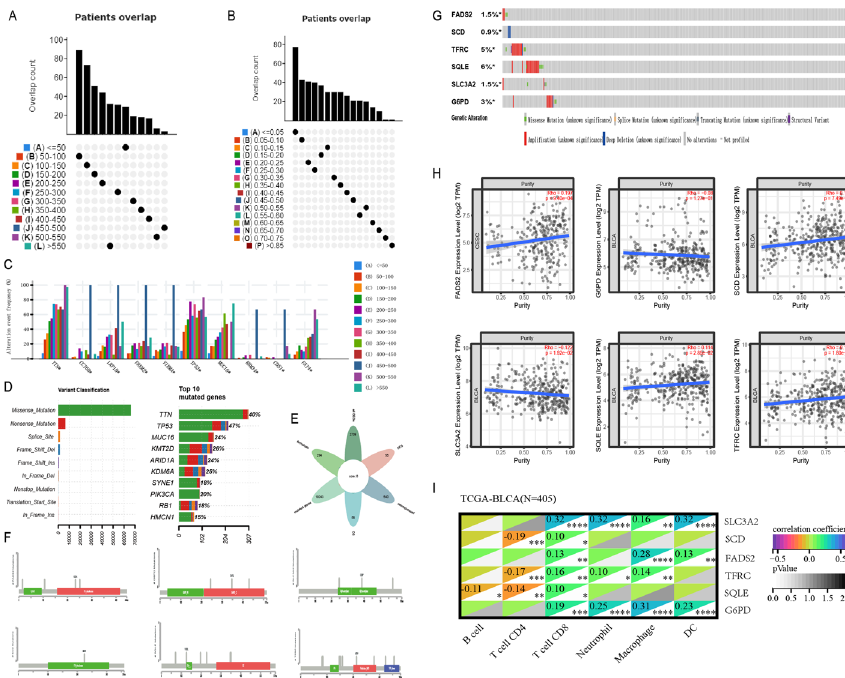
Fig. 3 Identification of potential tumor‑specific antigens of BCa. Samples overlapping in A mutation count groups and B altered genome fraction. C Genes with highest frequency in mutation count groups. D Summary of overall mutation results. E 6 candidates with high expression, mutation and significant association with OS and DFS. F , G The OncoPrint tab summarizes genomic alterations across TCGA set. H , I Identification of tumor antigens associated with tumor purity ( H ) and APCs ( I